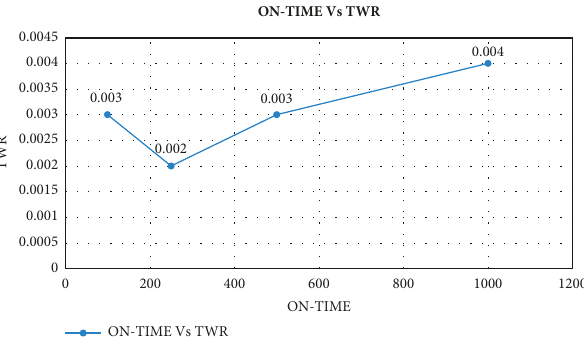
Figure 10: On-time versus